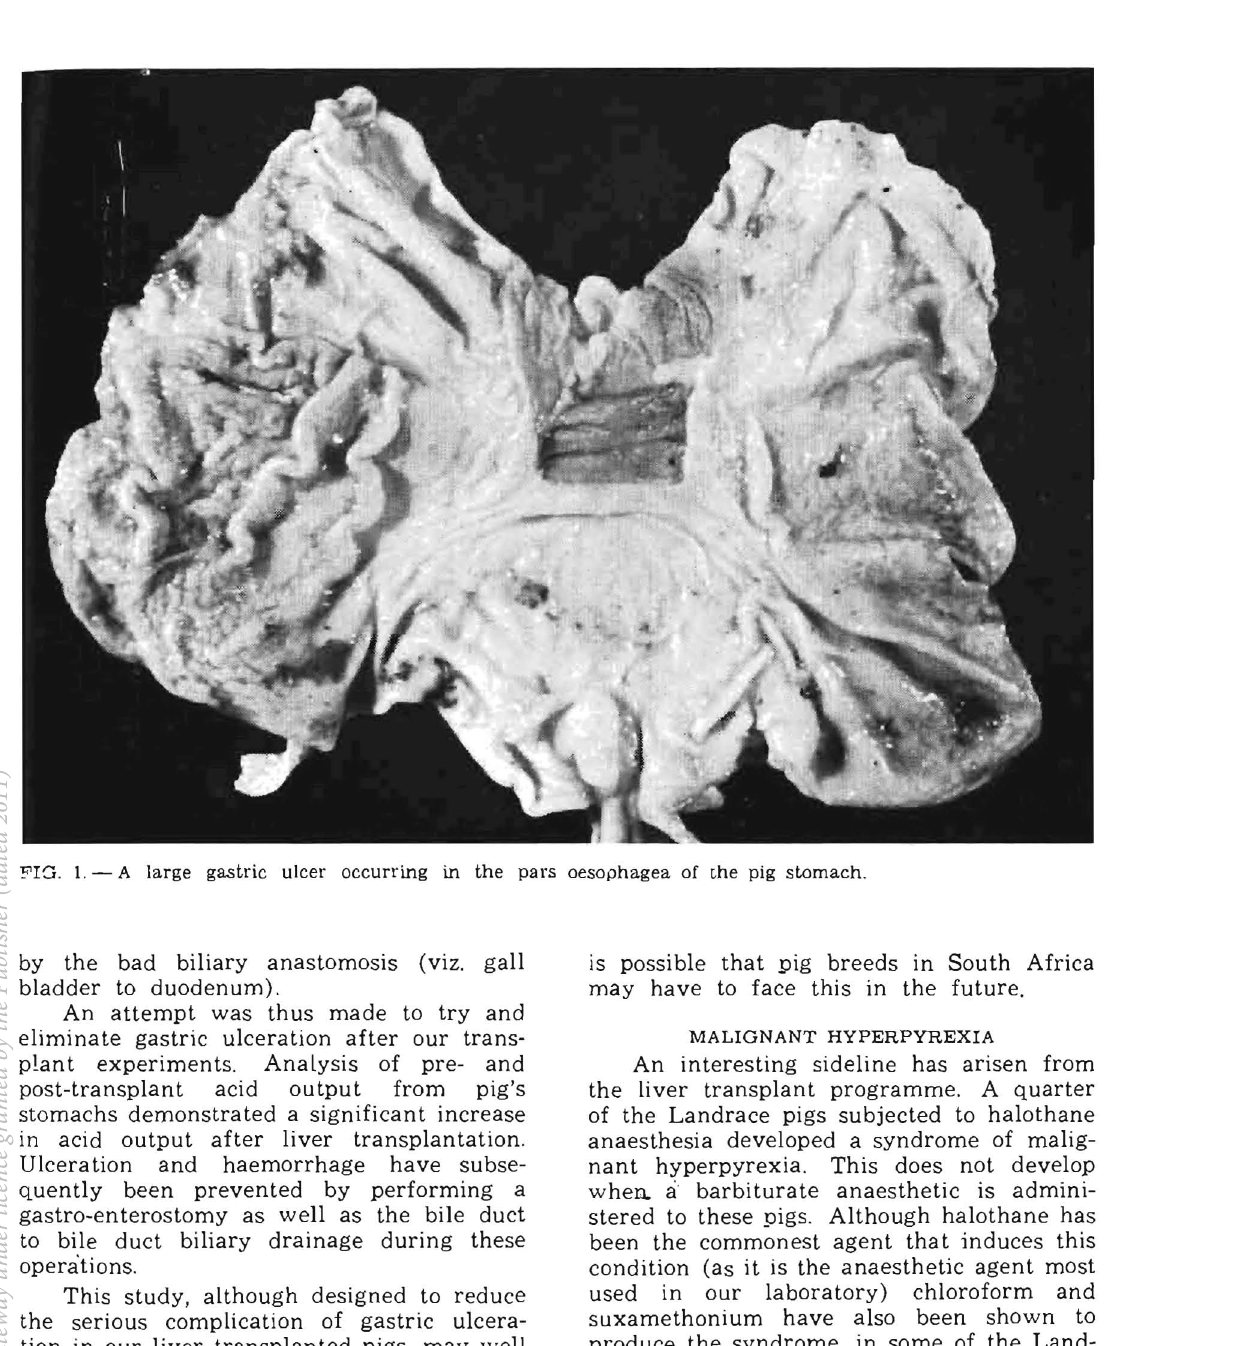
PIG. 1. - A large gastric ulcer occurring in the pars oesophagea of "he pig stomach.